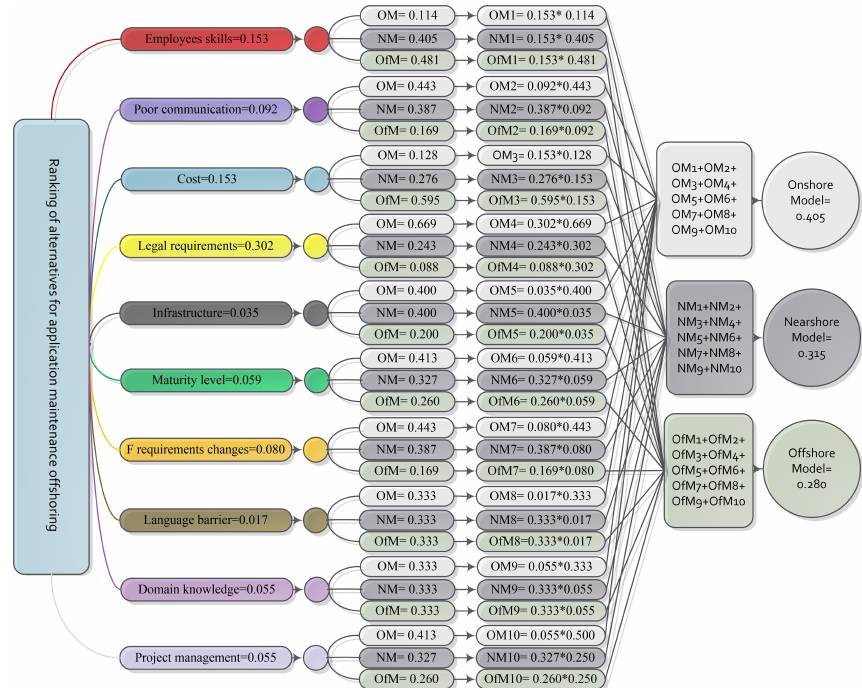
Figure 6. Ranking of sourcing